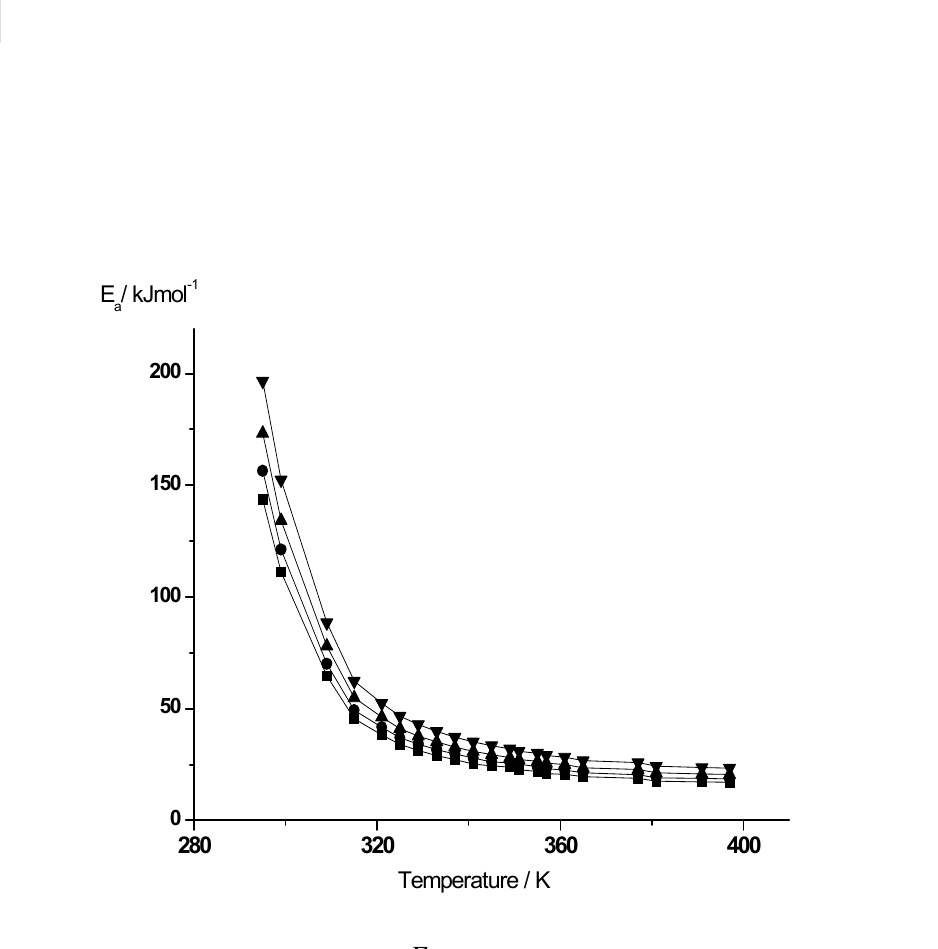
E on temperature at different heating rates: Figure 6 – The dependence of a ■ - 5 K min -1 , ● - 10 Kmin -1 ▲ - 15 K min -1 ▼ - 20 K min -1 E от температуры при различных скоростях нагревания Рис . 6 – Зависимость a Слика 6 –